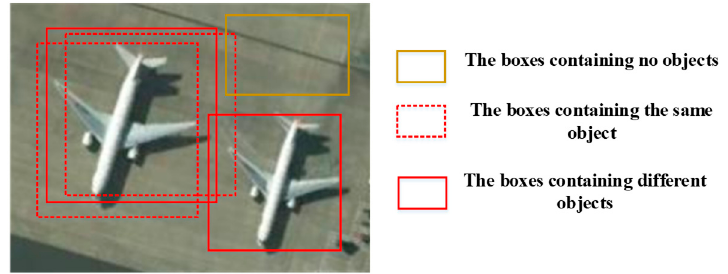
Figure 6. The examples of predicted bounding boxes generated in the region proposal stage.